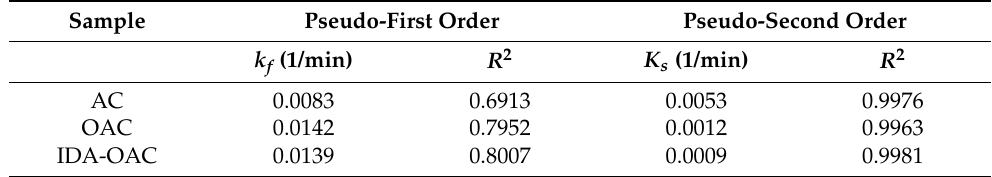
Figure 8. Linear plots of ( a ) pseudo-first-order kinetic and ( b ) pseudo-second-order kinetic models of AC, OAC, and IDA-OAC adsorption for Cu(II). Table 5. The fitting results of pseudo-first order and pseudo-second order kinetic models.